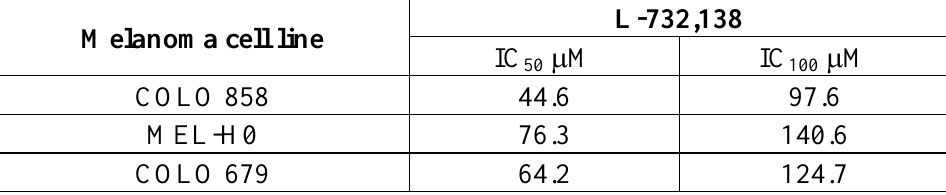
Table 1. Half inhibition (IC after administration of the NK-1 receptor antagonist